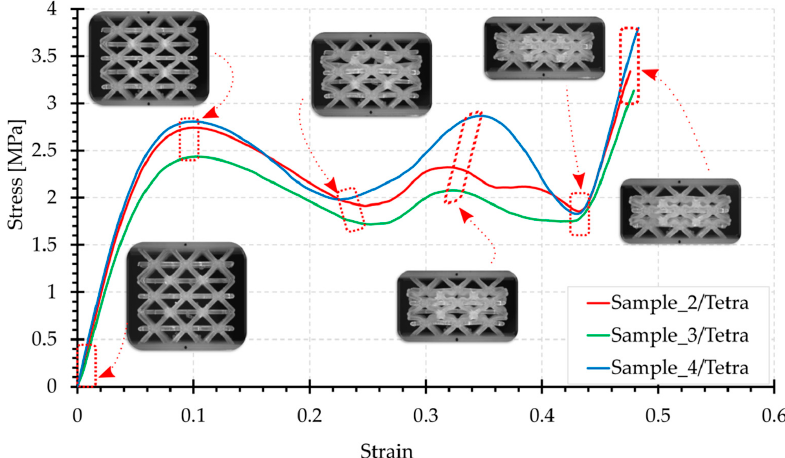
Figure 9. Compression curve for the Tetra structure with photographs of the topology at selected test phases.